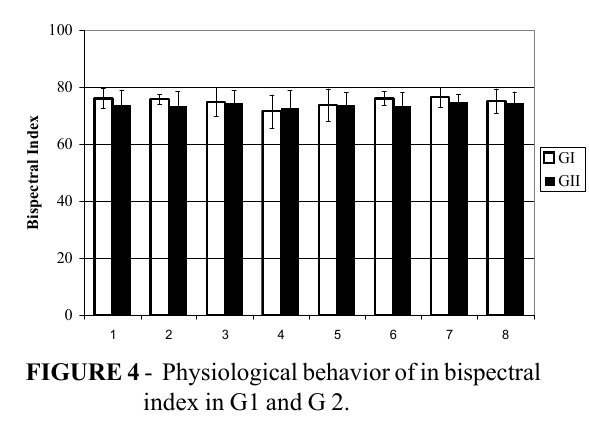
FIGURE 4 - Physiological behavior of in bispectral index in G1 and G 2.